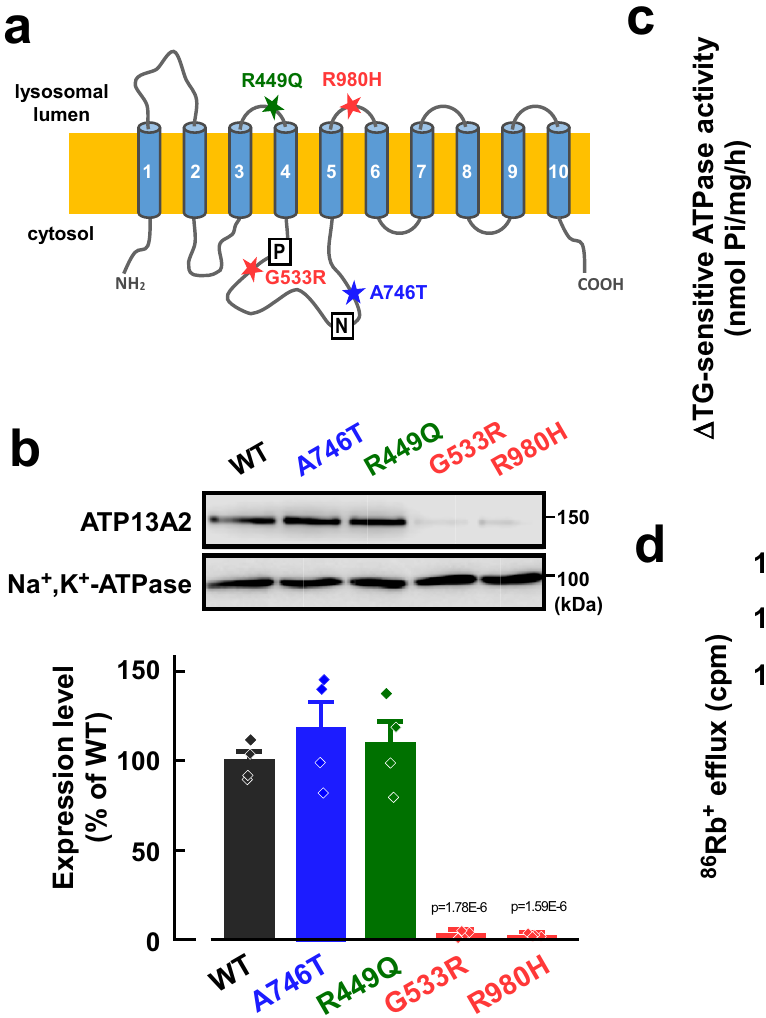
Fig. 2 | Effects of PD-associated mutations on ATP13A2-derived activity. a Topology model of human ATP13A2. PD-associated mutations (R449Q, G533R, A746T, and R980H), phosphorylation domain (P), and nucleotide-binding domain (N) are indicated. b Western blotting for ATP13A2 (~150kDa) and Na + ,K + -ATPase (~100kDa) in the ATP13A2 WT- and mutants-transfected HEK293 cells. Expression level of ATP13A2 was normalized to that of Na + ,K + -ATPase. The expression level of ATP13A2inWT-transfectedcellswastakenas100%.( n =4independentreplicates). Statistical signi fi cance was determined by two-tailed unpaired Student ’ s t test.